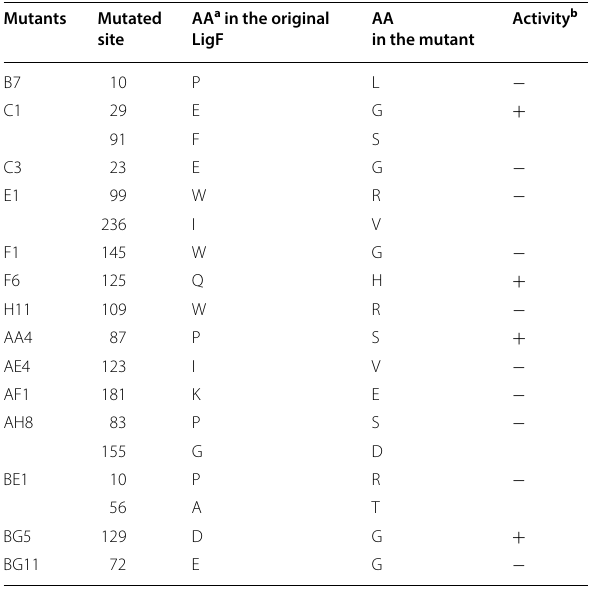
a AA indicates the abbreviation of amino acid. b “ activity was higher than that of the original LigF; “ activity was lower than that of the original LigF